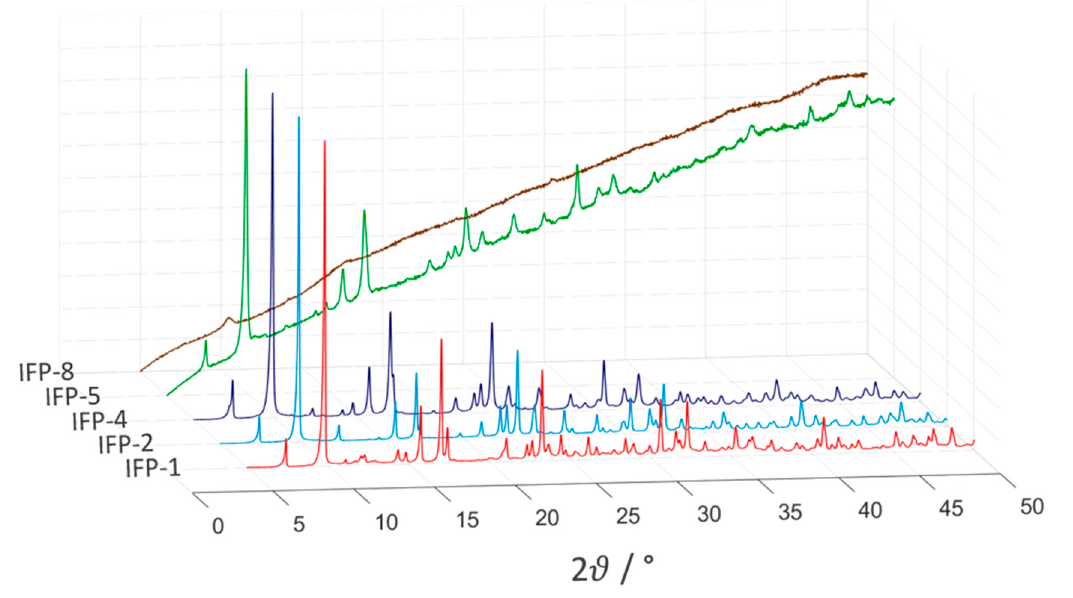
Figure 8. Normalized powder X-ray diffractograms of all IFP samples after water uptake experiments.